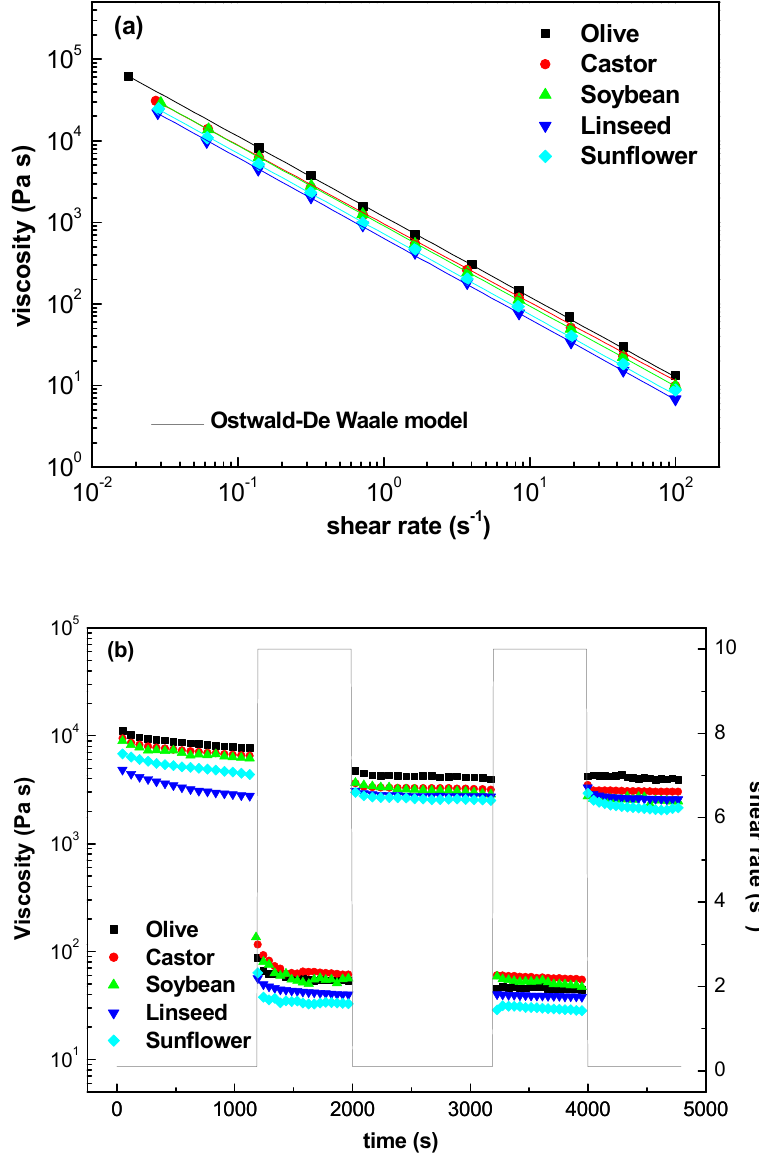
Figure 4. ( a ) Steady shear flow curves as a function of type of vegetable oil. Continuous lines represent fits to the Ostwald-de Waele model and, ( b ) Thixotropic and shear thinning properties of oleogels measured by plotting viscosity over time and at changing shear rates of 0.1 s − 1 and 10 s − 1 .